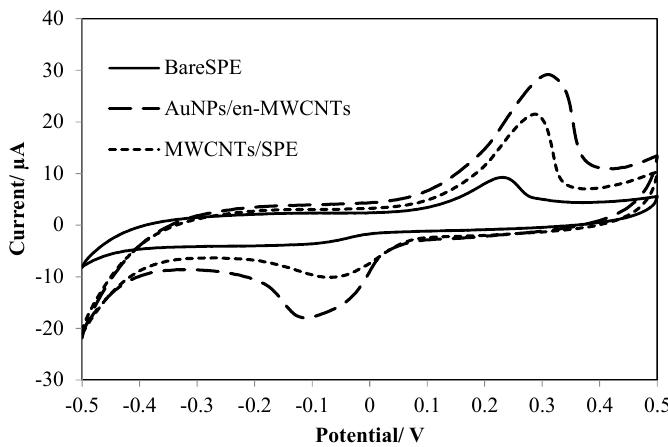
Figure 4. Cyclic voltammograms of 10 µM Amoxicillin on bare SPE and after modification with MWCNTs and AuNPs/en-MWCNTs in phosphate buffer (pH 4.0).